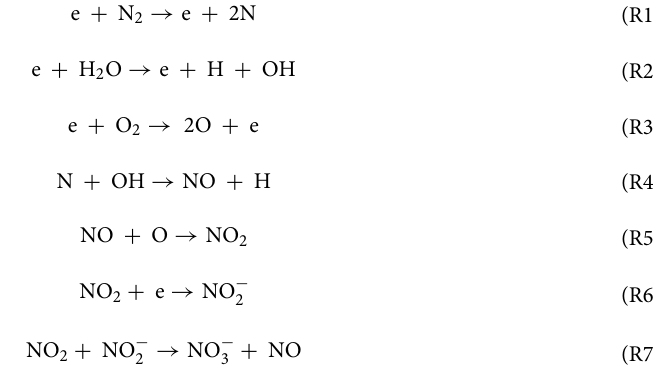
baseline (131) but was 141.53 ± 1.83 for seeds with plasma irradiation. The peak area was significantly higher in the extract w/ plasma ( p = 0.00012 as determined by a two-tailed t -test) than in the extract w/o plasma irradia- tion. These results strongly indicate that 62 m/z molecules generated by plasma irradiation were introduced in the seeds. Considering that the optical emission spectra of scalable dielectric barrier discharge (SDBD) plasma show NO (200–250 nm) 34 , a major candidate for peak X is nitrate ion (NO 3− ) among the long-lifetime species in air plasmas. NO 3− can be generated from the electron impact ionization reactions of N 2 , O 2 , and H 2 O in the gas phase as shown in the reactions (R1)–(R7) 35